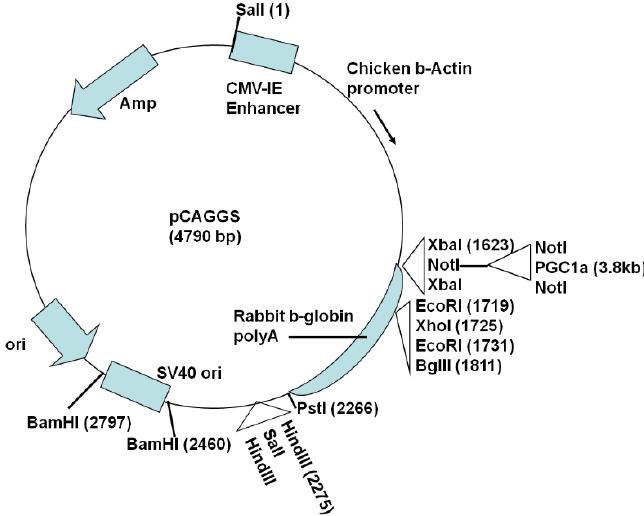
Figure 1. Plasmid construct for generation of actin-PGC-1 α transgenic mice. A Not I site was inserted at the vector Xba I site and a Sal I site inserted at the vector Hind III site on the pCAGGS plasmid. Human peroxisome proliferator-activated receptor gamma, coactivator 1 alpha (PGC-1 α ) cDNA was inserted in the Not I site and Sal I digestion released the fragment containing the cytomegalovirus immediate-early (CMV-IE) enhancer, chicken β -actin promoter, and hPGC-1 α that was used for microinjection. Sequence (5 (cid:48) –3 (cid:48) Table 1. PCR primers used in the study.